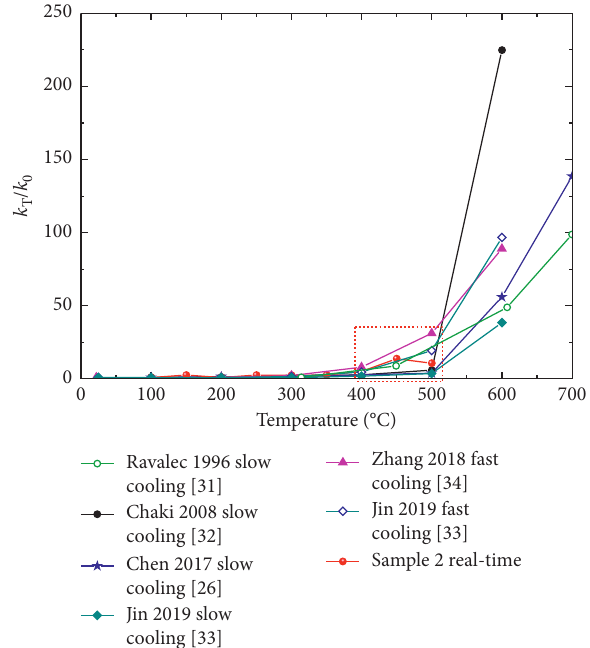
Figure 7: Comparison to permeability between real-time and heating-cooling